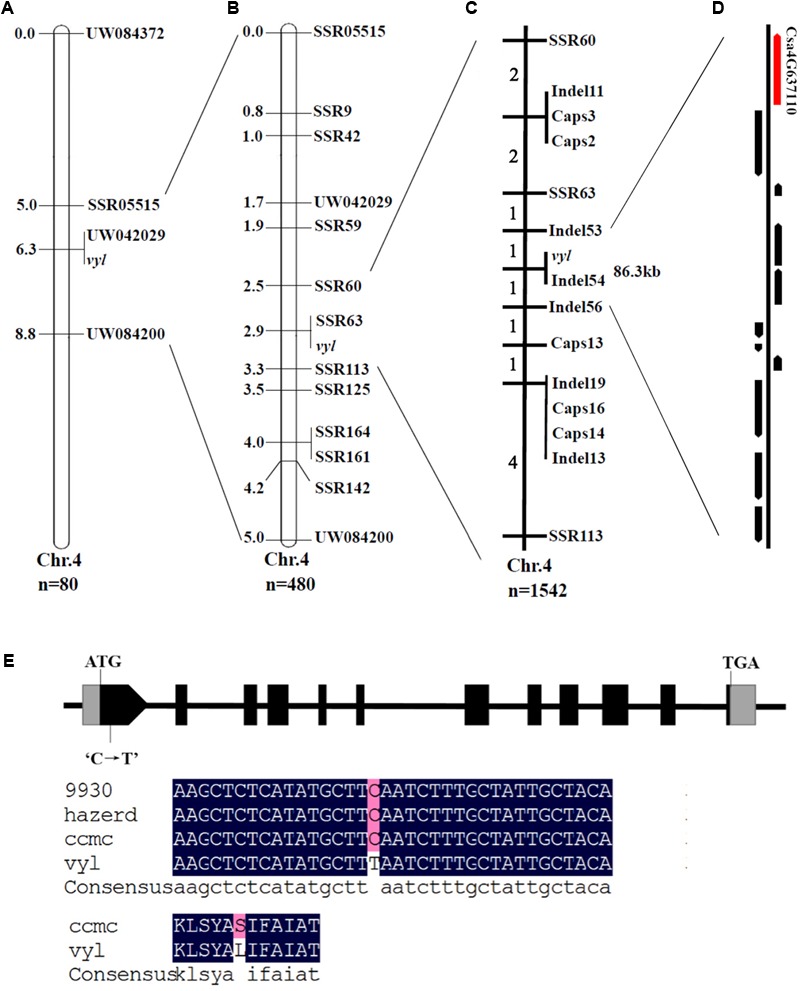
Positional cloning and sequence alignment of the CsVYL gene. (A) Preliminary mapping with BSA based on 80 plants from the F2 population placed CsVYL locus on chromosome 4 at a 3.8 cM region between UW804200 and SSR05515. Numbers on chromosome left are genetic distance (cM); (B) Further genetic position analysis with 480 F2 individuals delimited the CsVYL locus at a 0.8 cM region; (C) Fine mapping of the CsVYL locus with 1542 individuals. The CsVYL gene was narrowed down to an 86.3 kb genetic region. Numbers on chromosome left are recombinants of each interval; (D) 11 annotated genes were predicted in the 86.3 kb region. Csa4G637110 is shown as the red arrow. (E) Gene and protein sequence alignment of CsVYL gene in 9930, Hazerd, ccmc and vyl Gray boxes, black boxes and lines between them indicate 5′ and 3′UTR, exons and introns respectively.